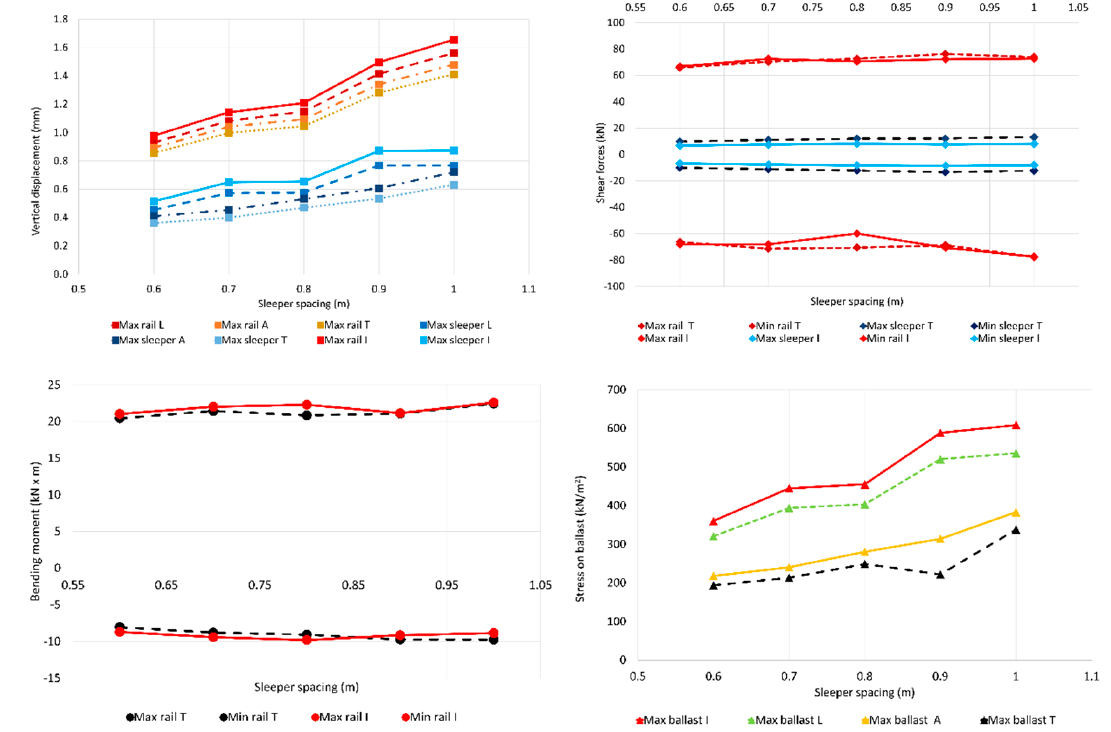
Figure 7. Case 5. Maximum vertical displacements of the rail and sleeper, shear forces on rail and sleeper, rail bending moments, and stresses on ballast (A—change the sleeper width, L—change the sleeper length, T—change both width and length, I—initial size of the